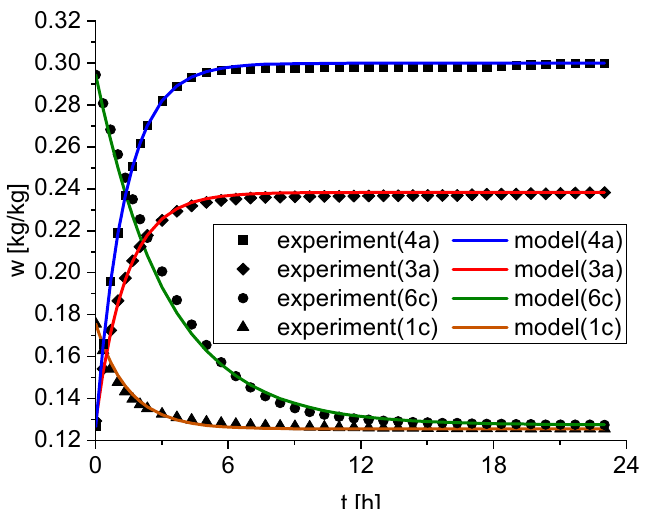
Figure 3. Comparison of the experiment and the model for four representative subsets (4a, 3a, 6c, 1a). The solid lines correspond to the model and the symbols are the experiment.